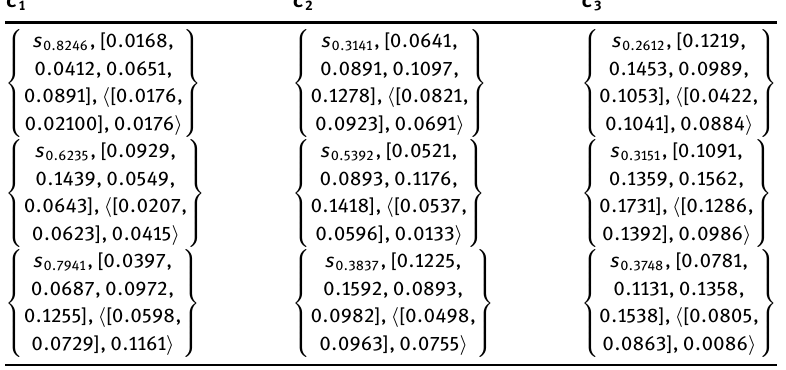
Table 4: The Normalized Trapezoidal Linguistic Cubic Fuzzy TOPSIS Decision Matrix. C 1 C 2 C 3